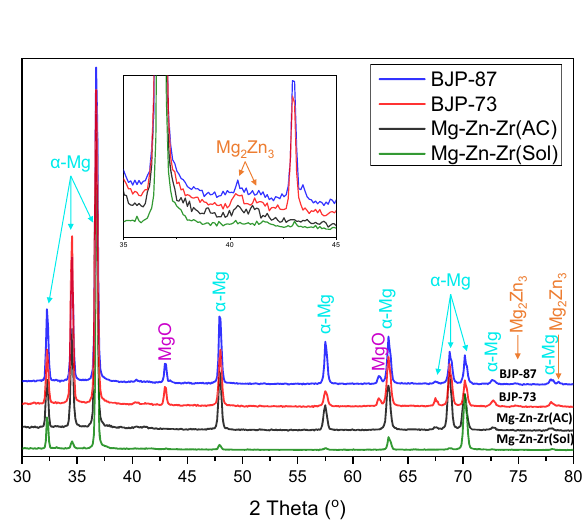
Fig. 3 XRD patterns of casted and BJP additive manufactured Mg- Zn-Zr alloys. XRD comparison between BJP-87, BJP-73, Mg – Zn – Zr (AC) and Mg – Zn – Zr(Sol).